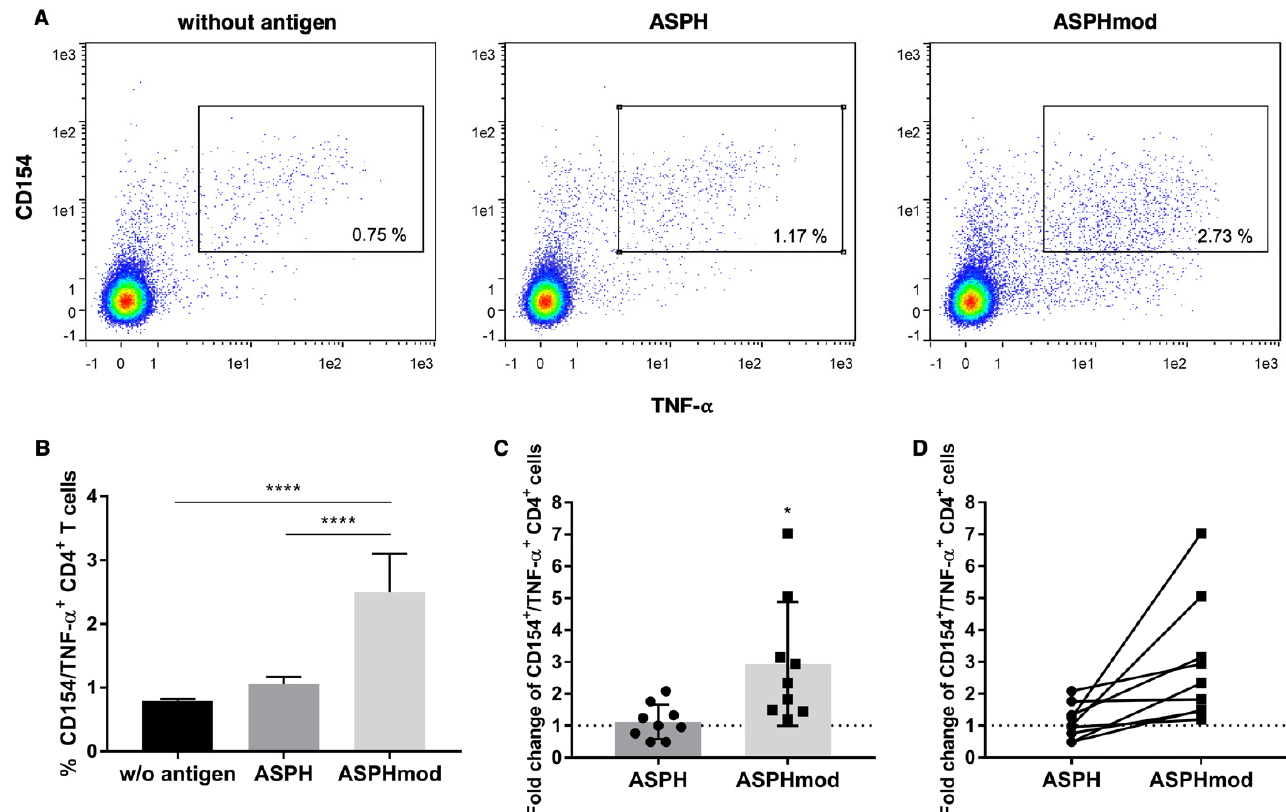
Figure 4. ASPHmod-pulsed moDCs induce an increase in CD4 + CD154 + TNF- α + T cells. ( A ) Repre- sentative flow cytometric analysis of a single individual. ( B ) Data represent the means ± SD of the same individual assessed in quintuplicate: **** significantly different, p < 0.001 (one-way ANOVA). ( C ) Fold change in CD4 + CD154 + TNF- α + T cells relative to cells restimulated with the non-pulsed moDC control. Data represent the means ± SD of nine individuals: * significantly greater, p < 0.05 (unpaired Student’s t test). ( D ) Relative T cell response of each individual to ASPH- versus ASPHmod-pulsed moDCs.